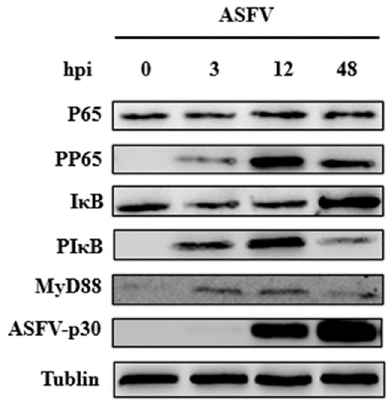
Figure 5. The expression of proteins in PAMs infected by ASFV. Variation in the trend of P65, PP65, I κ B, PI κ B, MyD88, and p30 proteins after 0, 3, 6, 12, and 48 h infection with ASFV duration by Western Blotting.